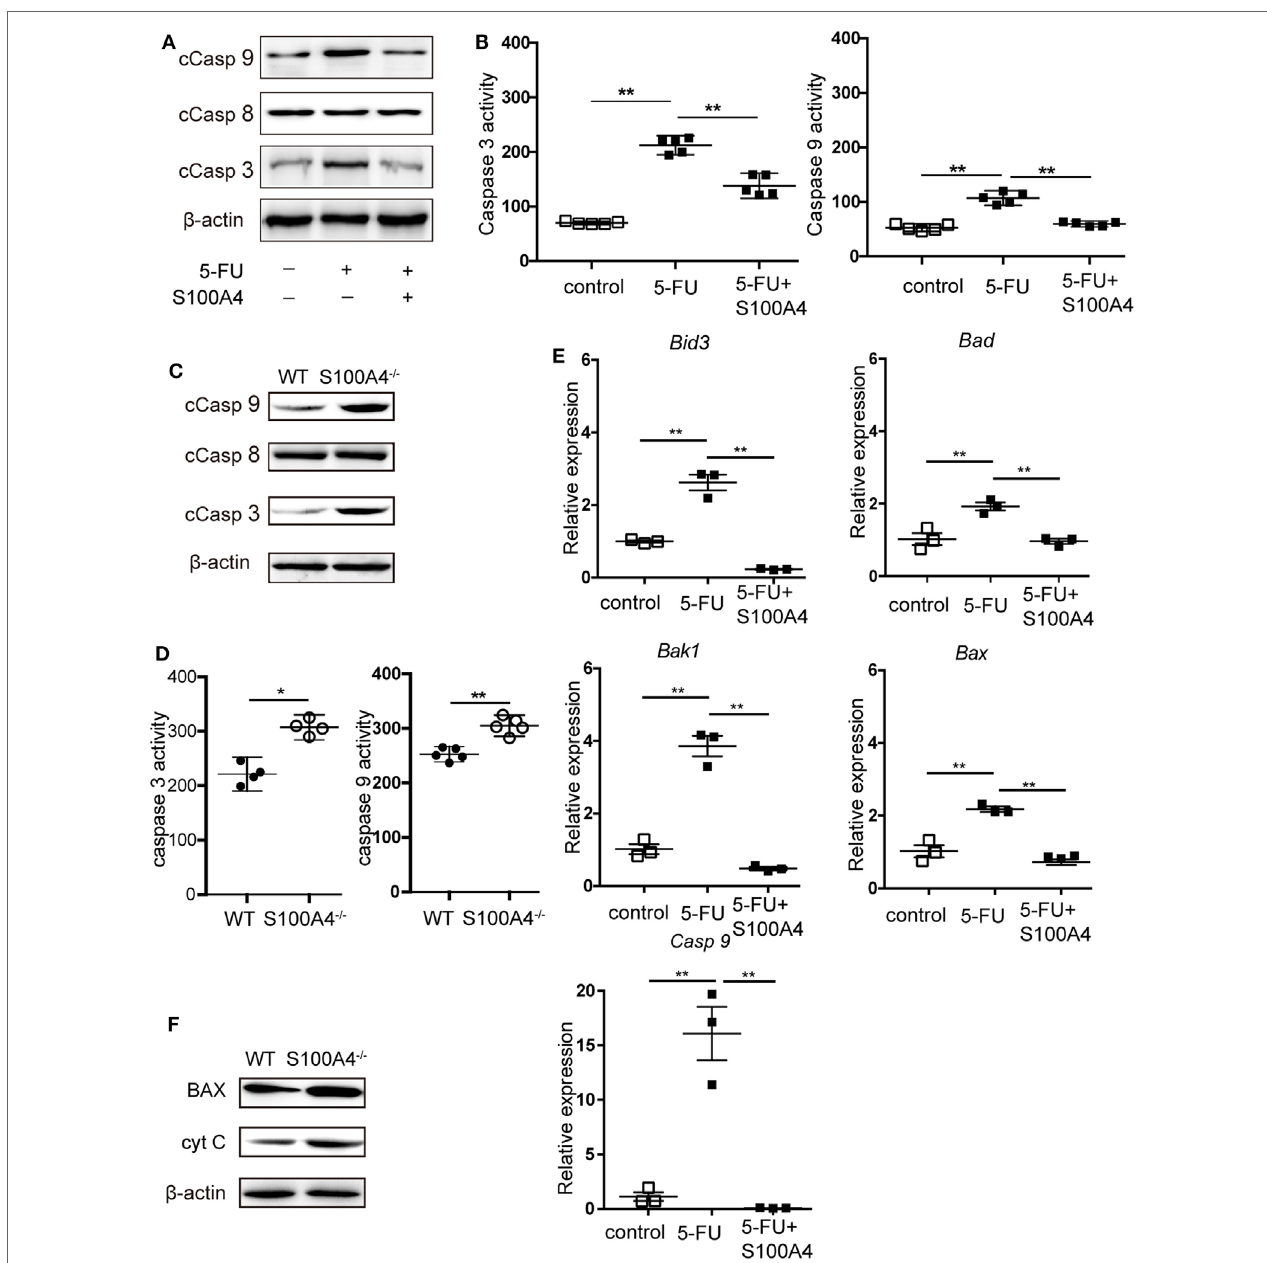
FigUre 4 | Effect of S100A4 on caspase activation and mitochondrial markers upon 5-FU-induced apoptosis in myeloid-derived suppressor cells (MDSCs). (a) MSC2 cells were treated with 5-fluorouracil (5-FU) or 5-FU and S100A4 (1 µg/mL) for 24 h; cleaved caspase (Casp)-3 (17 kDa), cleaved Casp-8 (18 kDa), and cleaved Casp-9 (37 kDa) proteins were evaluated by western-blot analysis. β -actin (42 kDa) served as a loading control. Representative images for three independent experiments are shown. (B) MSC2 cells were treated with 5-FU alone or in the presence of S100A4, as indicated. Cleaved caspase-3 and cleaved caspase-9 activities were determined by colorimetric activity assays. Representative results for three independent experiments are shown. Mean and 95% CI, n = 5 per group; ** P < 0.01, Mann–Whitney. (c) Total cell lysates from purified MDSCs were subjected to western-blot analysis for cleaved caspase-3, cleaved caspase-8, or cleaved caspase-9. β -actin served as a loading control. Representative results for three independent experiments are shown. (D) Cleaved caspase-3 and cleaved caspase-9 activities from lysates of splenic CD11b + GR1 + cells from tumor-bearing wild type (WT) and S100A4 − / − mice were determined by colorimetric assays. Representative results of three independent experiments are shown. Mean and 95% CI, n = 4–5 per group; ** P < 0.01, Mann–Whitney. (e) The mRNA expression levels of BH3 interacting-domain death agonist ( Bid3 ), Bcl-2-associated death promoter ( Bad ), Bcl-2-associated X protein ( Bax ), Bcl-2 homologous antagonist/killer ( Bak1 ), and caspase-9 ( Casp9 ) in MSC2 cells were detected by quantitative RT-PCR. Expression was normalized to that of Actb . Representative results from three independent experiments are shown. Mean ± SEM, n = 3 per group; ** P < 0.01, ANOVA. (F) Total cell lysates of splenic CD11b + GR1 + cells from tumor-bearing WT and S100A4 − / − mice were subjected to BAX (20 kDa) or cytochrome c (CytC; 12 kDa)-specific western-blot analysis. β -actin served as loading control. Representative results of three independent experiments are